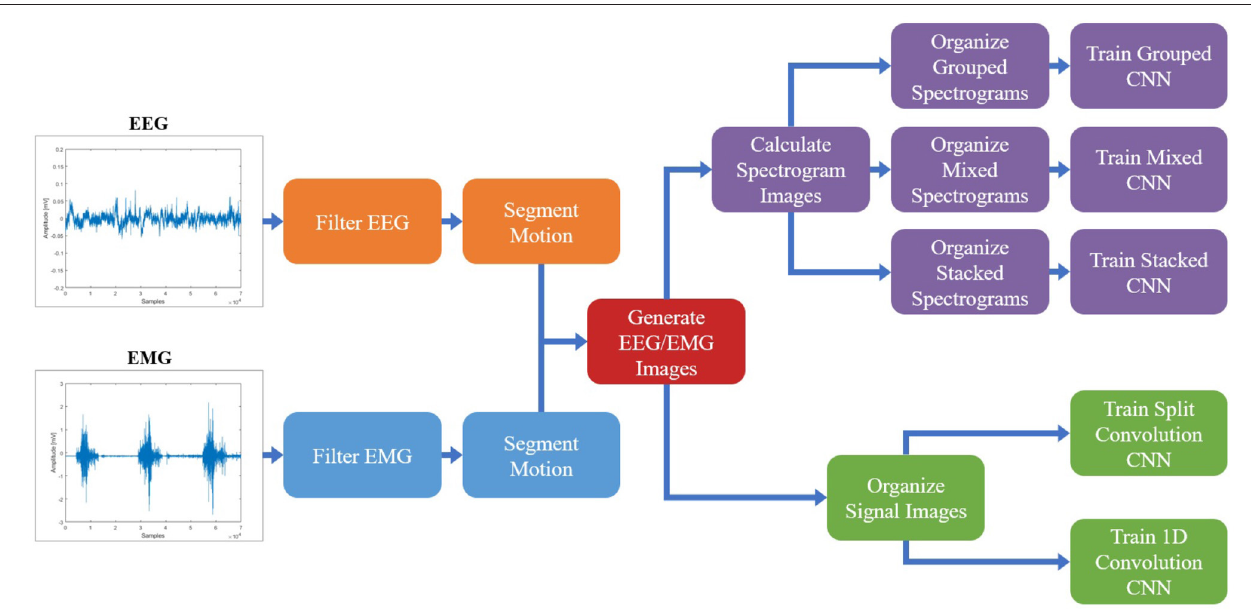
FIGURE 1 | The protocol followed to process the EEG/EMG signals, generate the spectrogram and signal images, and train the CNN models using different EEG–EMG fusion methods. The top path (purple) shows the steps used to develop the CNN models based on spectrogram image inputs, while the bottom path (green) shows the steps used to develop the CNN models based on signal image inputs. For all EEG–EMG-fusion-based CNN model types (represented by the final step of all paths), an EEG and EMG only version was also trained, to provide a baseline comparison for evaluating EEG–EMG